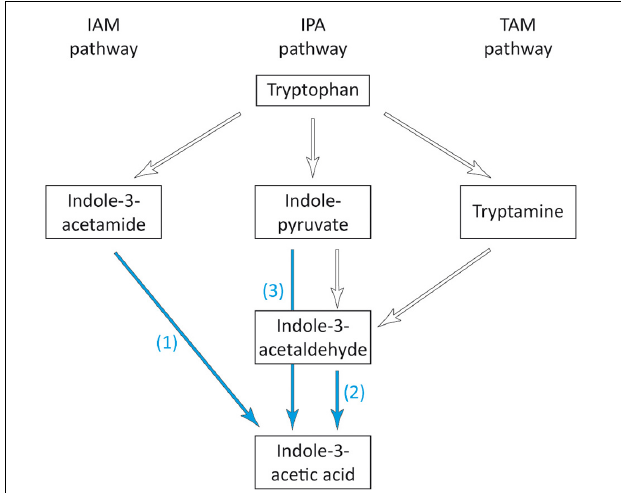
FIGURE 6 | Overview of the bacterial IAA biosynthetic pathways adapted from Spaepen and Vanderleyden (2011). Blue arrows indicate the presence of enzymes detected in Stenotrophomonas sp. 169: (1) amidase AmiE, EC 3.5.1.4, (2) aldehyde dehydrogenase, EC 1.2.1.3, (3) indole-pyruvate ferredoxin oxidoreductase, EC